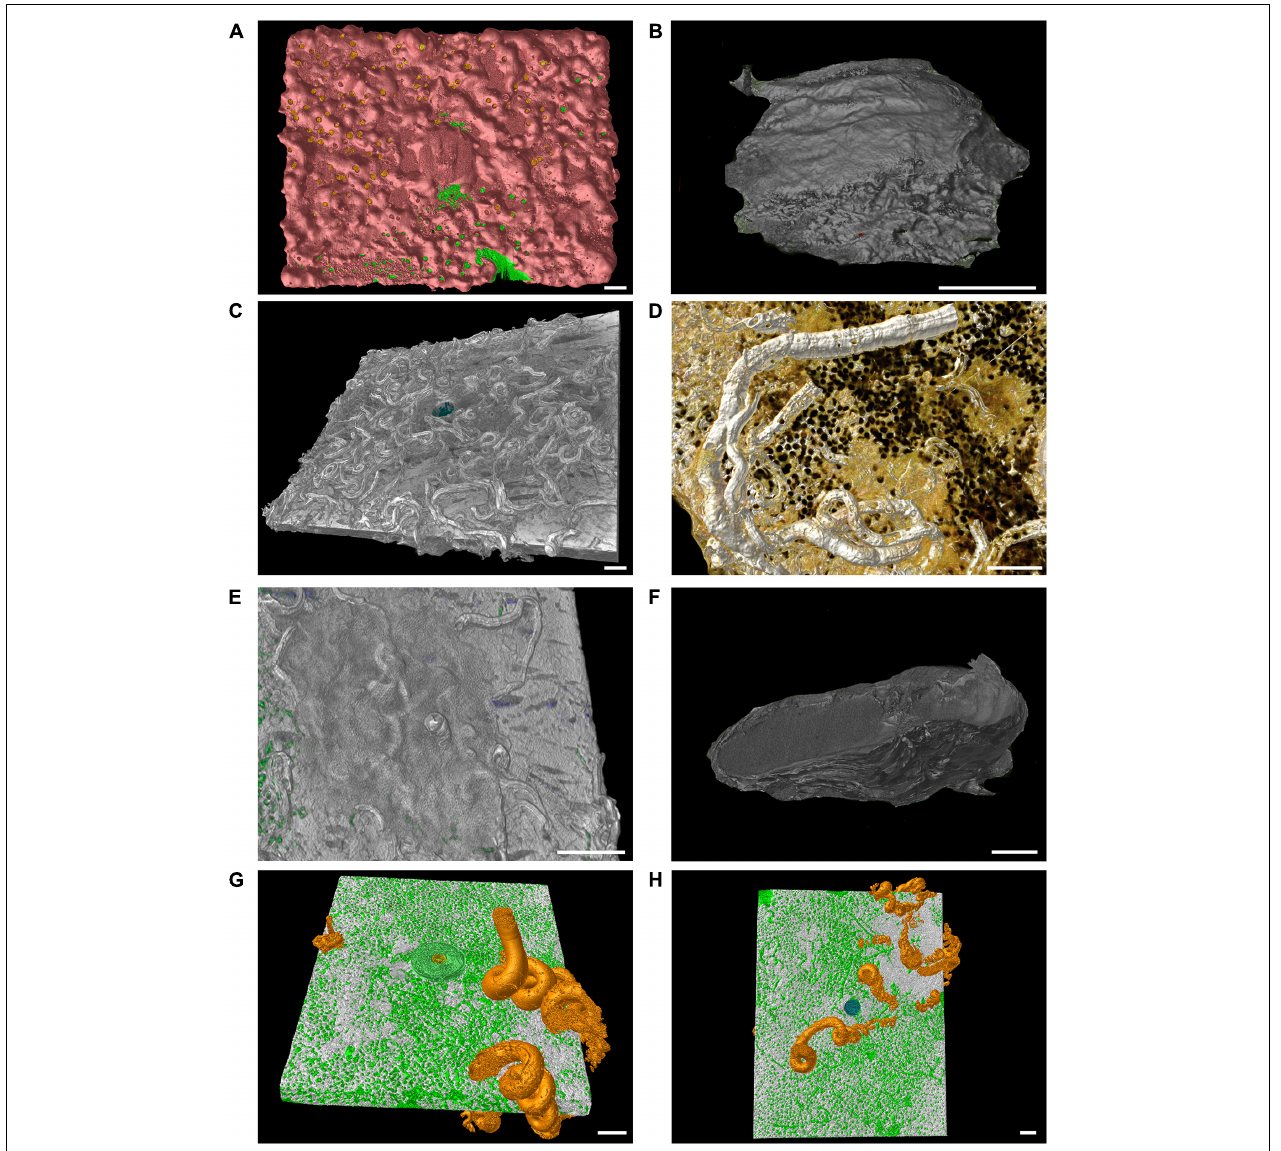
FIGURE 2 | Computed tomography graphic reconstruction of calcareous organisms grown on travertine tiles. (A) Coverage of encrusting calcareous rhodophytes (pink) at MR08 after 12 years. (B) A shell of Anomia ephippium at P204 after 3 years. (C) Serpulid polychaetes tubes (mainly Spirobranchus triqueter ) at P204 site after 3 years. (D) Tubes of the serpulid polychaetes Serpula concharum at MR08 after 12 years. (E) The encrusting bryozoan Schizomavella ( Schizomavella ) linearis which covered the serpulid polychaetes tubes at MR08 after 3 years, in green traces of boring sponges inside the tile. (F) A shell of Magallana gigas found at P204 after 3 years. (G,H) The shell of the vermetid Thylacodes arenarius (bright orange) in the same tile (top and bottom view, respectively) at MR08 after 12 years, in green traces of boring sponges inside the tile. Scale bars are 1 cm